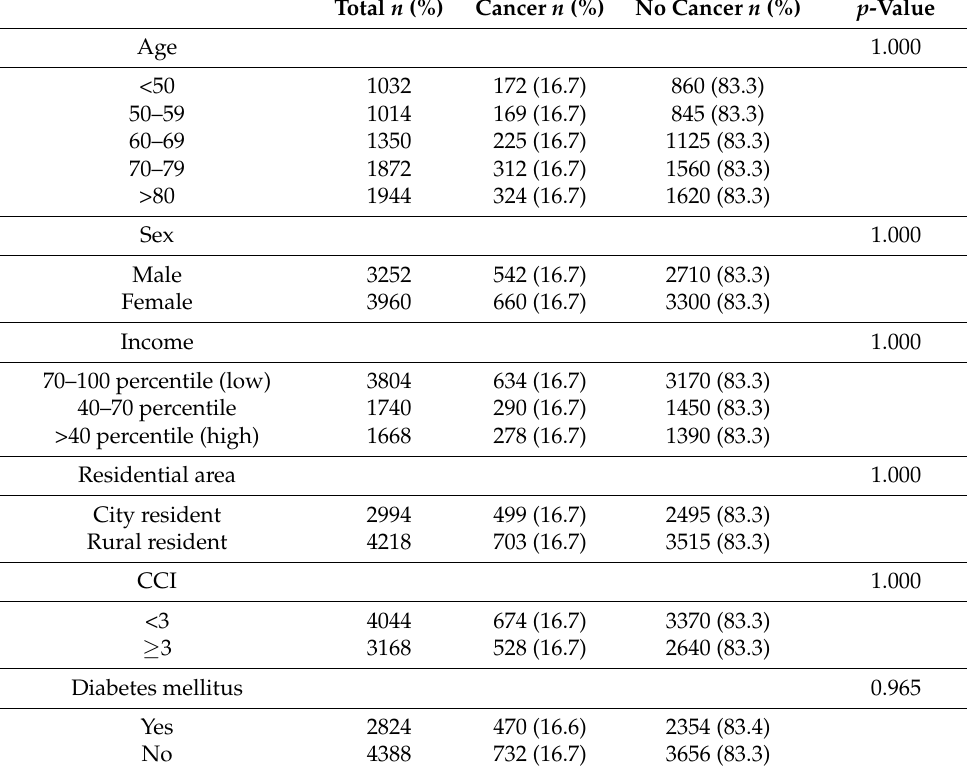
Table 2. Demographic characteristics of the population included in the study.